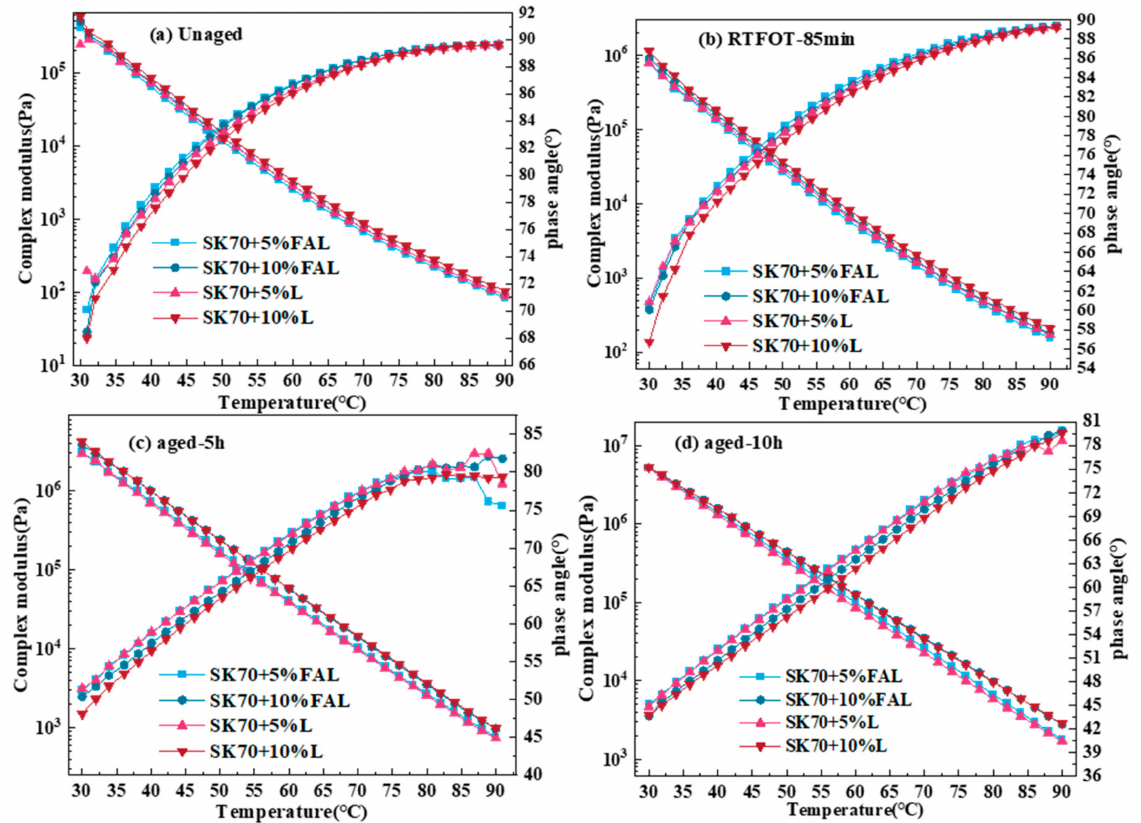
Figure 5. Variation curves of complex modulus G* and phase angle δ with temperatures for each asphalt specimen in different aging